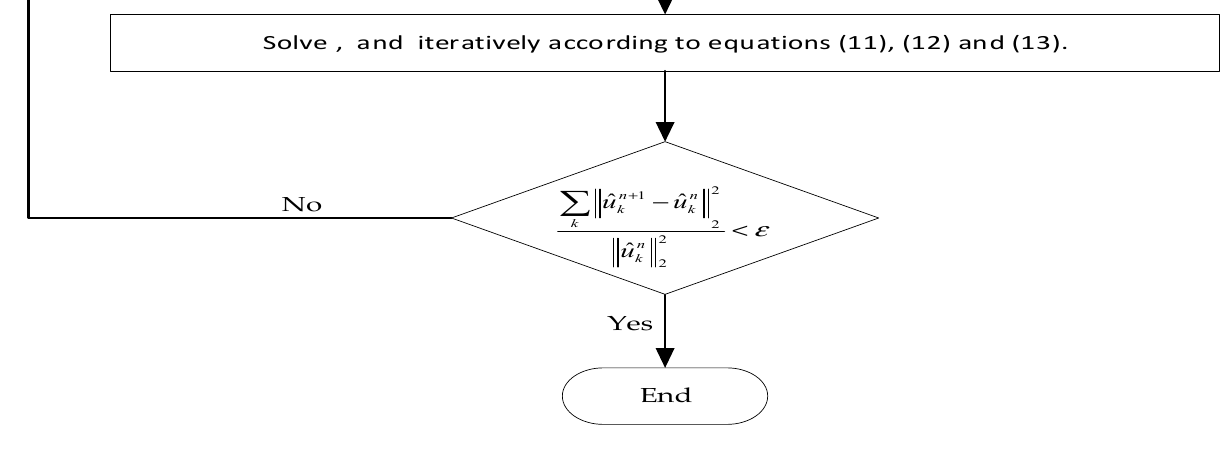
Figure 3. VMD calculation